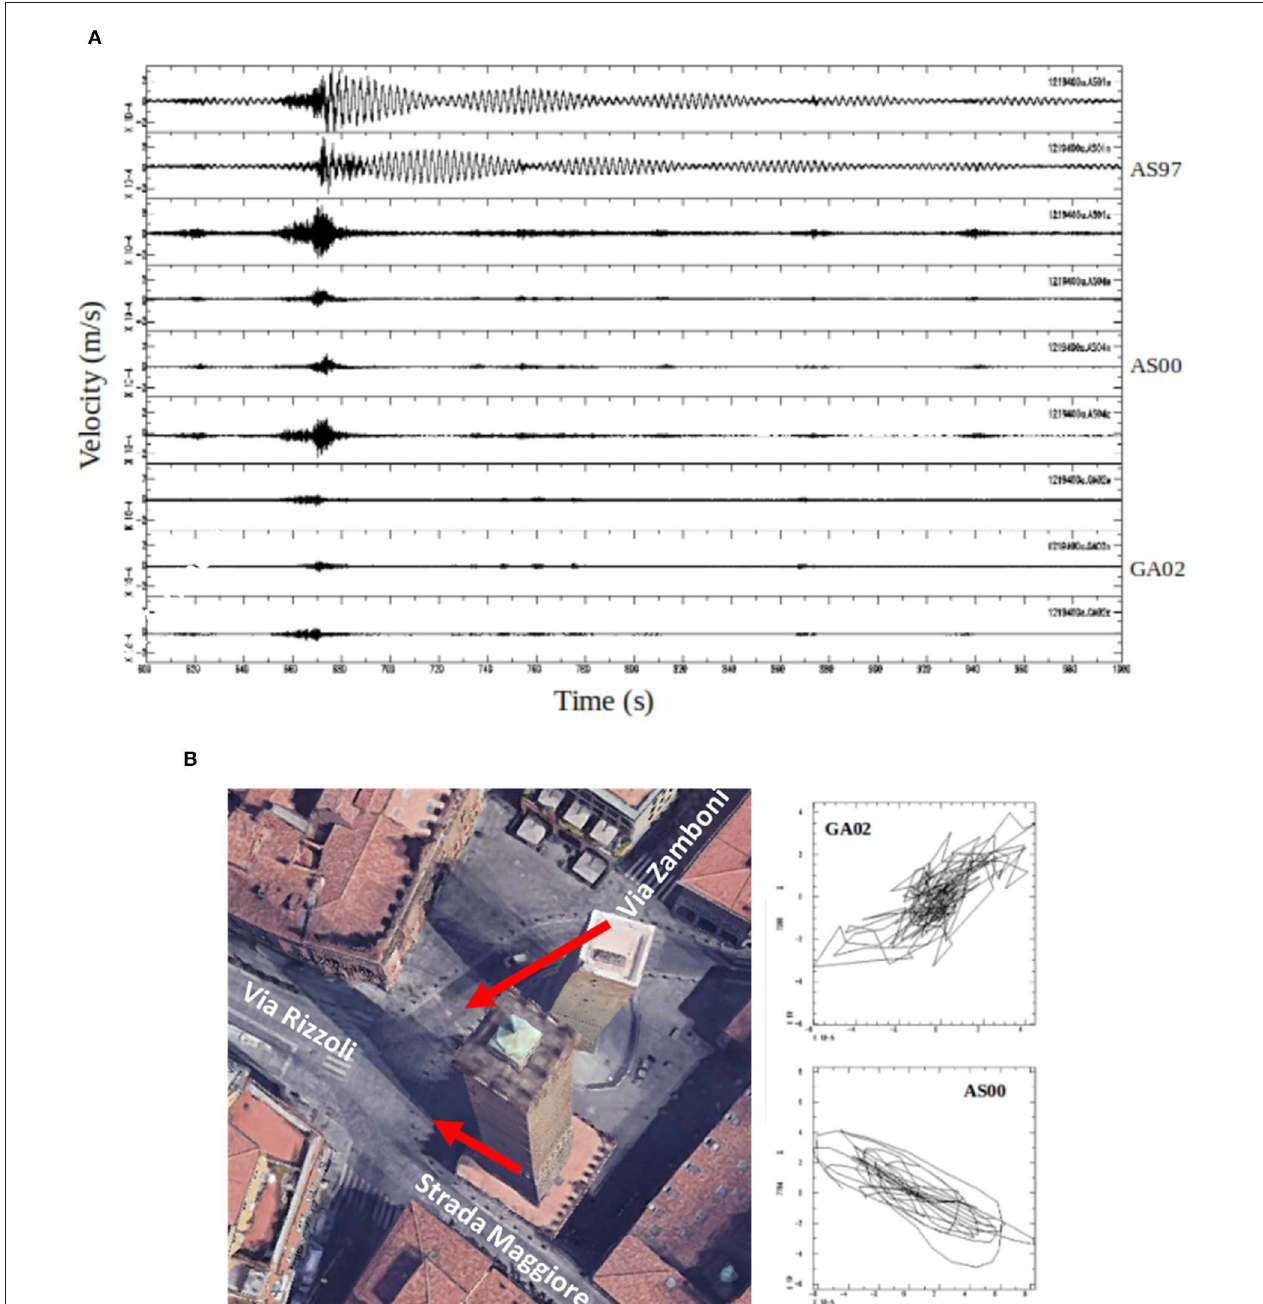
FIGURE 9 | (A) Example of transient propagating inside the Towers and triggering beatings at the Top level of Asinelli Tower. Each set of three signals are the waveforms on the Z, NS, EW directions, from down to top, respectively, for GA02, AS00, and AS97 measurements point. (B) Particle motion analysis along the horizontal directions for the two seismic stations installed at the base of the Two Towers.